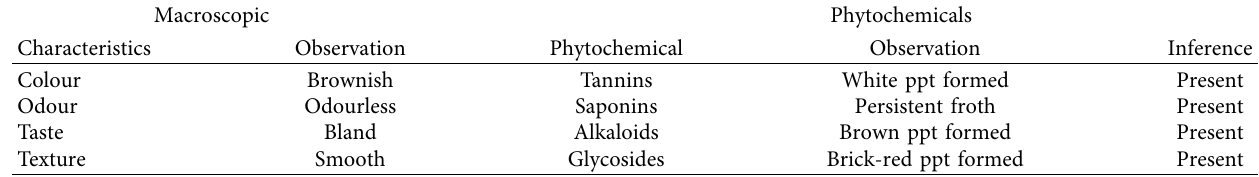
Table 2: Macroscopic properties and phytochemical constituents of the gum of Melia azedarach .